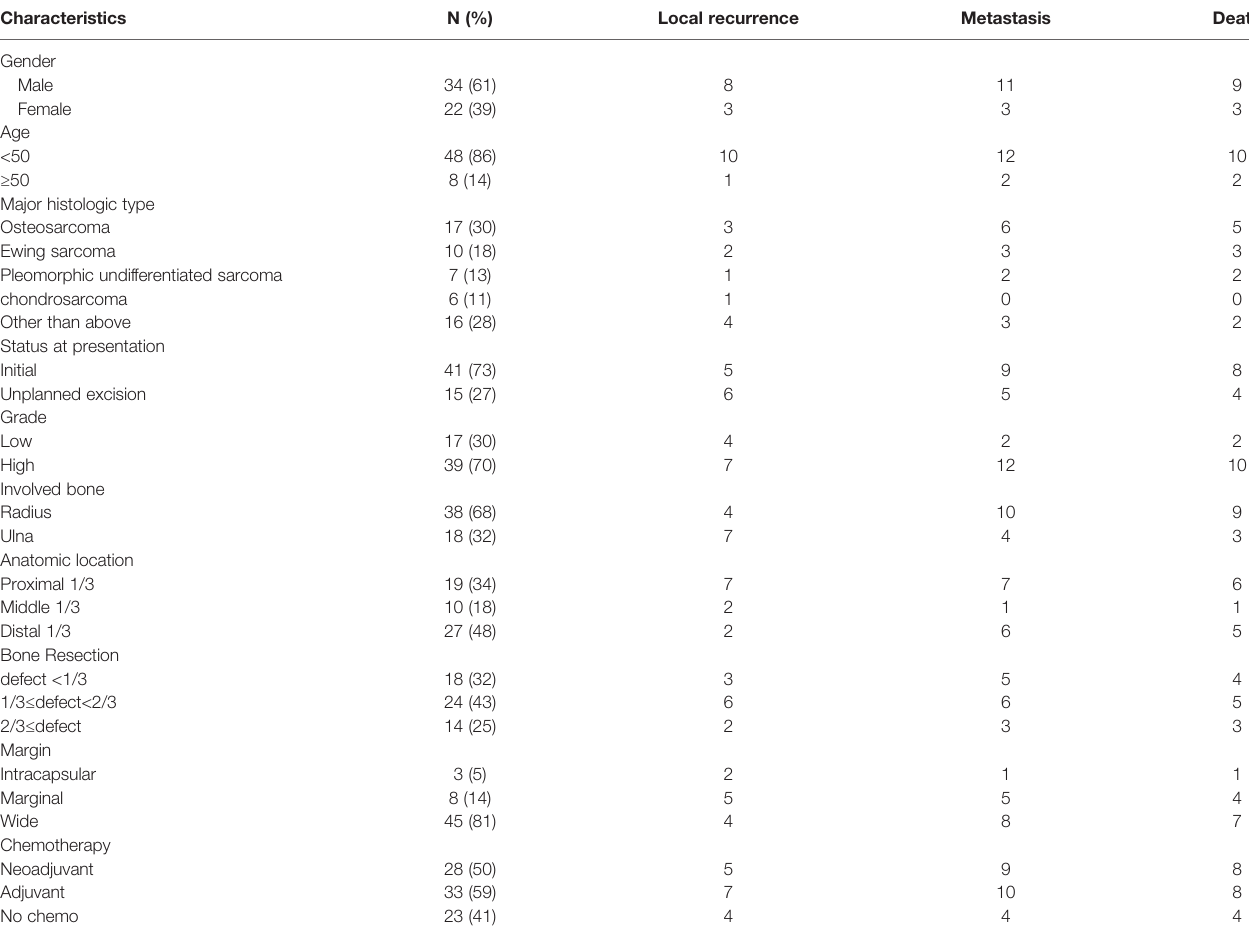
TABLE 1 | Patients, Tumor Characteristics and Outcomes in 56 Patients.